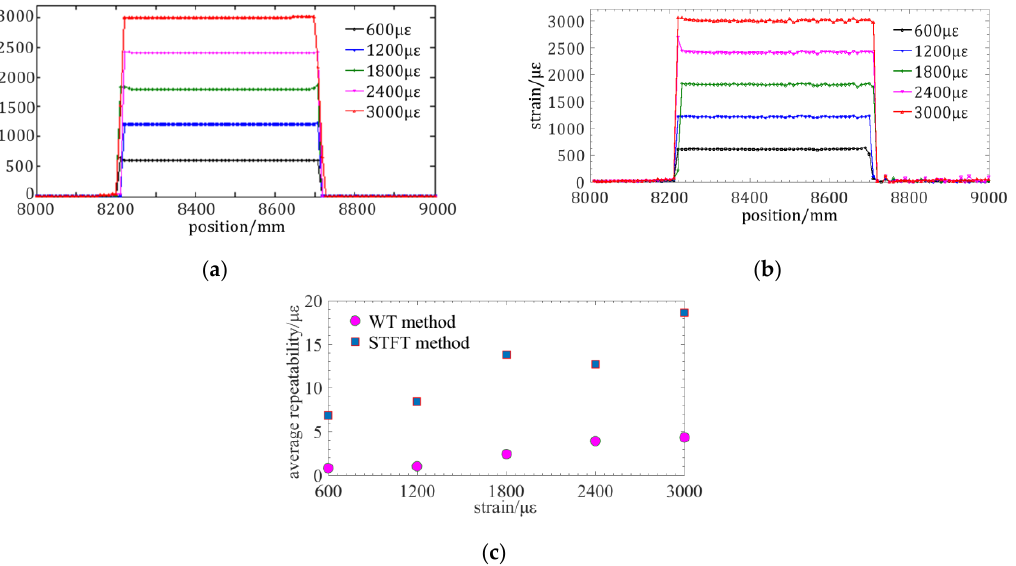
Figure 10. Experiment on the average repeatability of the distributed strain: ( a ) distributed strain